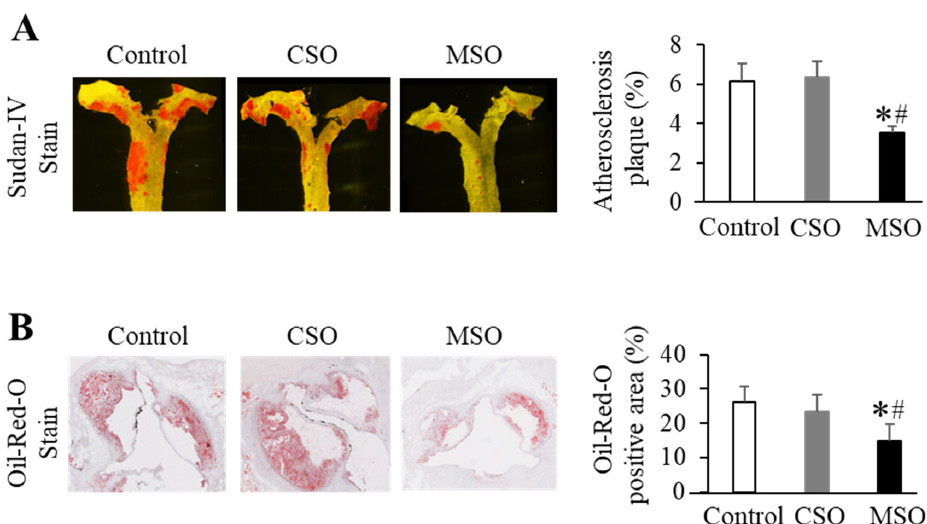
Figure 3. Effects of dietary CSO and MSO on progression of atherosclerosis in LDLR-KO mice. Mice (n = 12/group) were fed a Western diet supplemented with 5% ( w / w ) CSO, MSO, or none (control) for 12 weeks. ( A ) Representative en face Sudan IV staining of aorta ( left ) and quantitative analysis of Sudan IV-positive plaque area of aorta ( right ). ( B ) Representative Oil-Red O staining of aorta sinus (left ) and quantitative analysis of cross-sectional Oil Red O-positive area of aortic sinus ( right ). CSO: conventional soybean oil, MSO: modified soybean oil. Values represent the mean ± SEM. * p < 0.05 compared with the control Western diet; # p < 0.05 compared with the CSO diet.